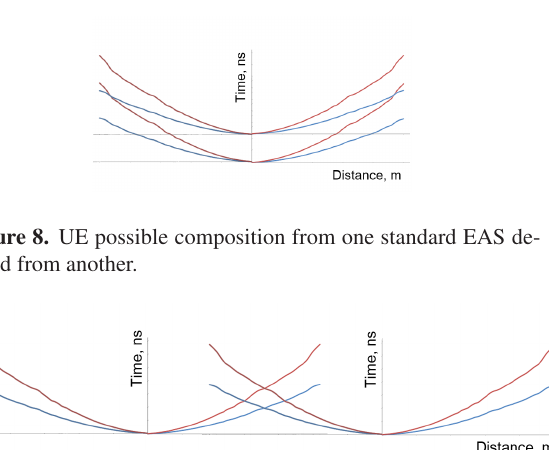
Figure 9. UE possible composition from two standard EAS next to each other.